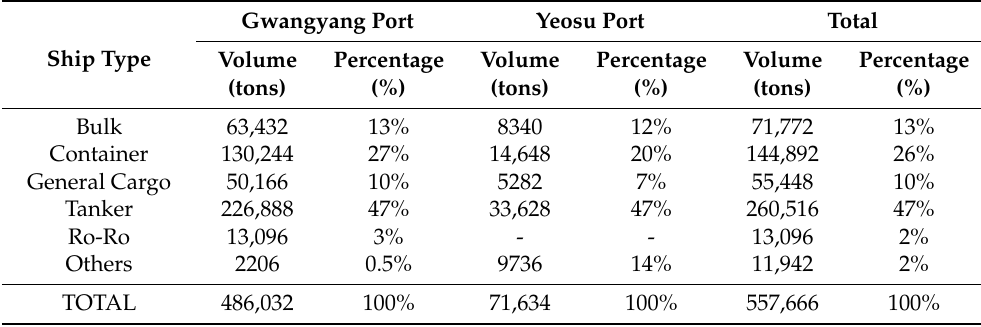
Table 7. Ship emissions by ship type.